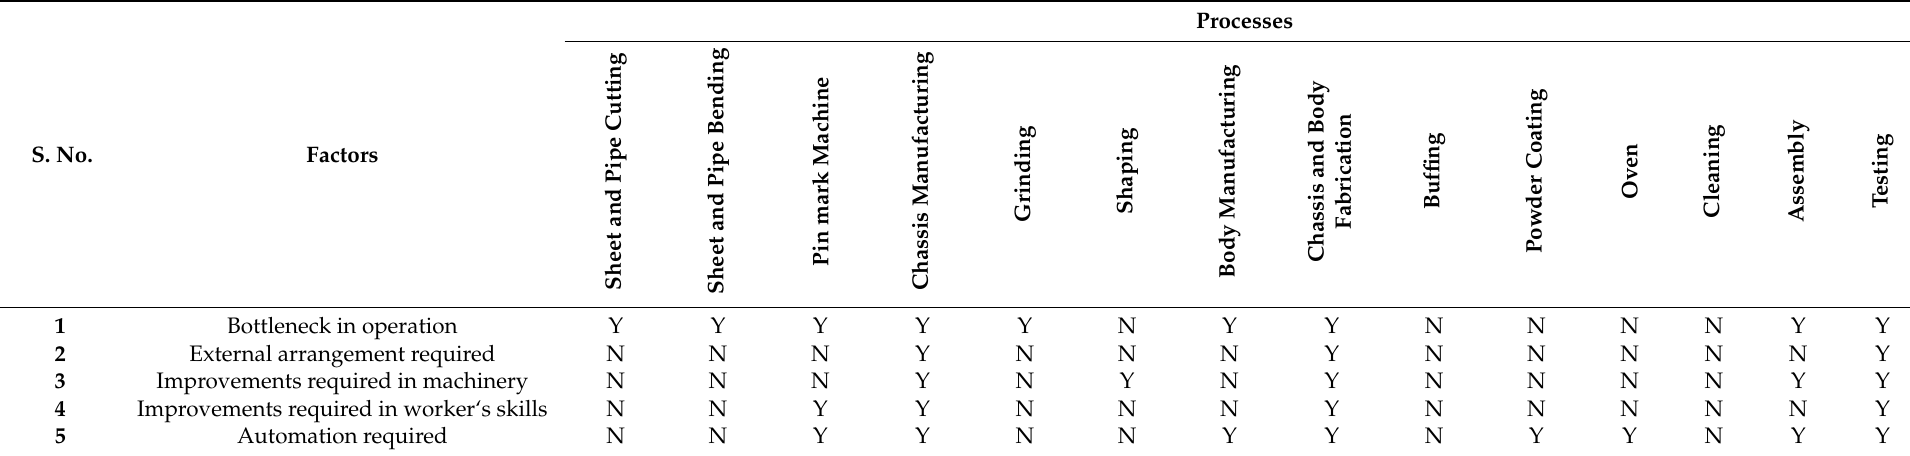
Table 9. Implemented factors according processes in industry A.